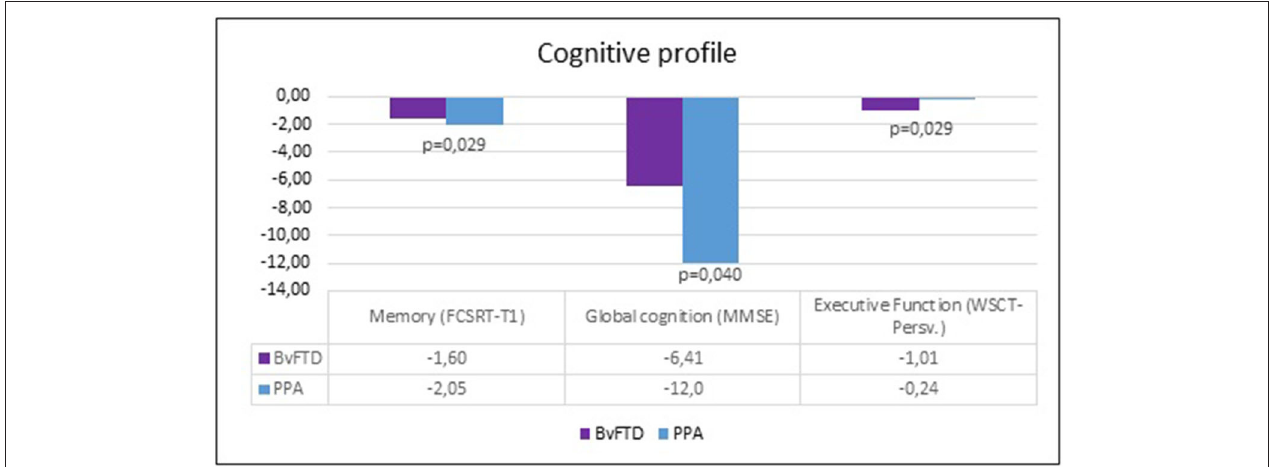
FIGURE 1 | Global cognition, memory, and executive functions between FTD and PPA patients.